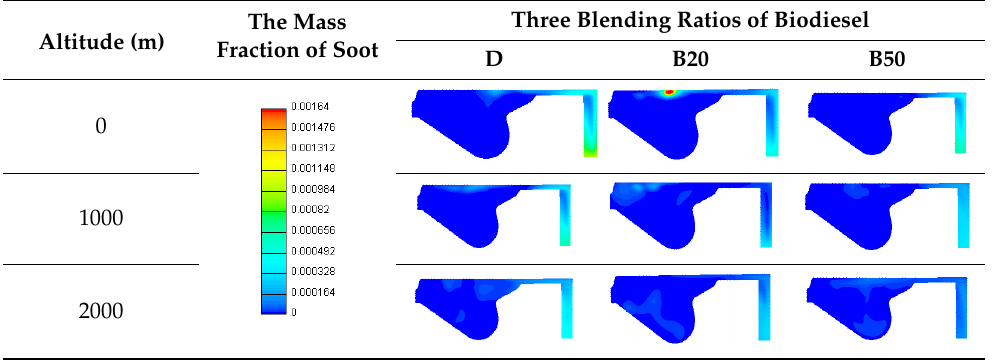
Table 6. Effect of different plateau environments on soot distribution field of cylinder with three blending ratios.